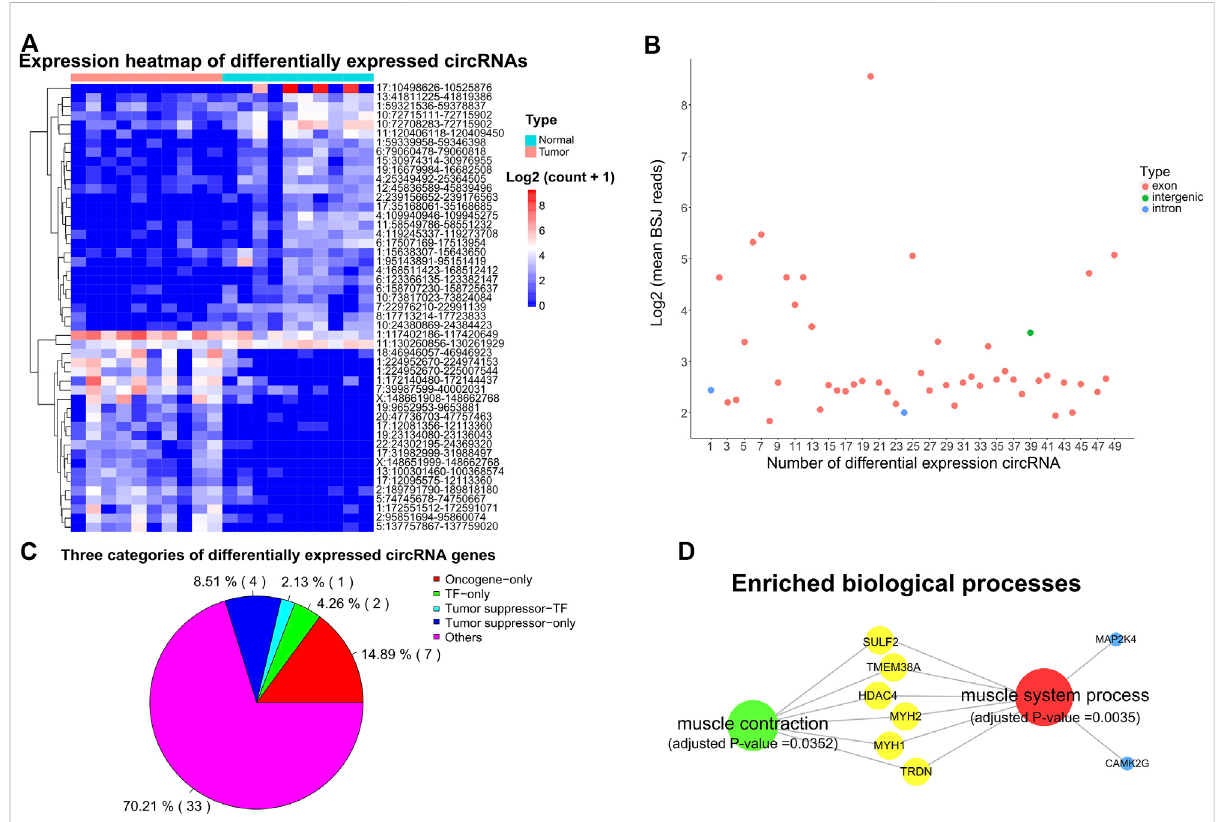
FIGURE 4 Expression pro fi le and characteristics of circRNAs. (A) Expression heatmap showing the differentially expressed circRNAs. Supporting reads of circRNAswereusedintheheatmap. (B) GenomicregionofthedifferentiallyexpressedcircRNAs.BSJ:back-splicedjunction. (C) Distincttypesofthe parental genes of differentially expressed circRNAs. (D) Signi fi cantly enriched biological processes for the parental genes of differentially expressed circRNAs. Adjusted p -value < 0.05.